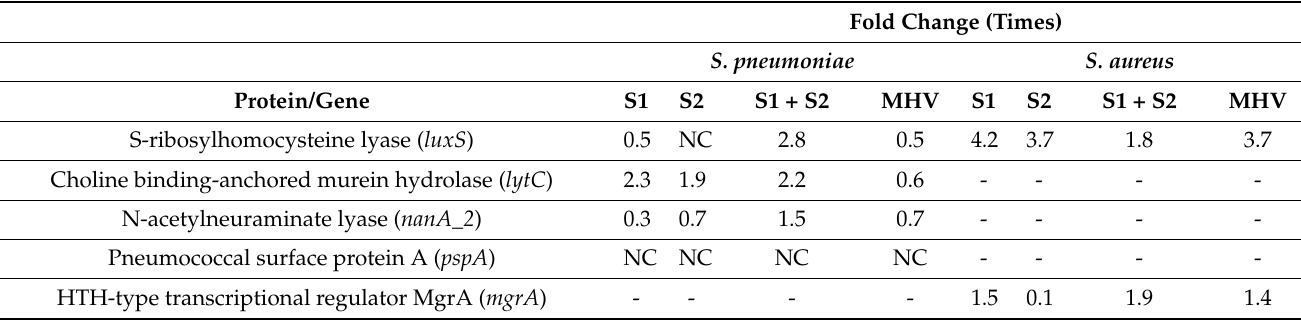
Table 3. Differentially expressed proteins with their indicated fold change relative to the bacterial con- trol. The fold change of each annotated protein was calculated based on protein content (percentage) estimated from the exponentially modified protein abundance index